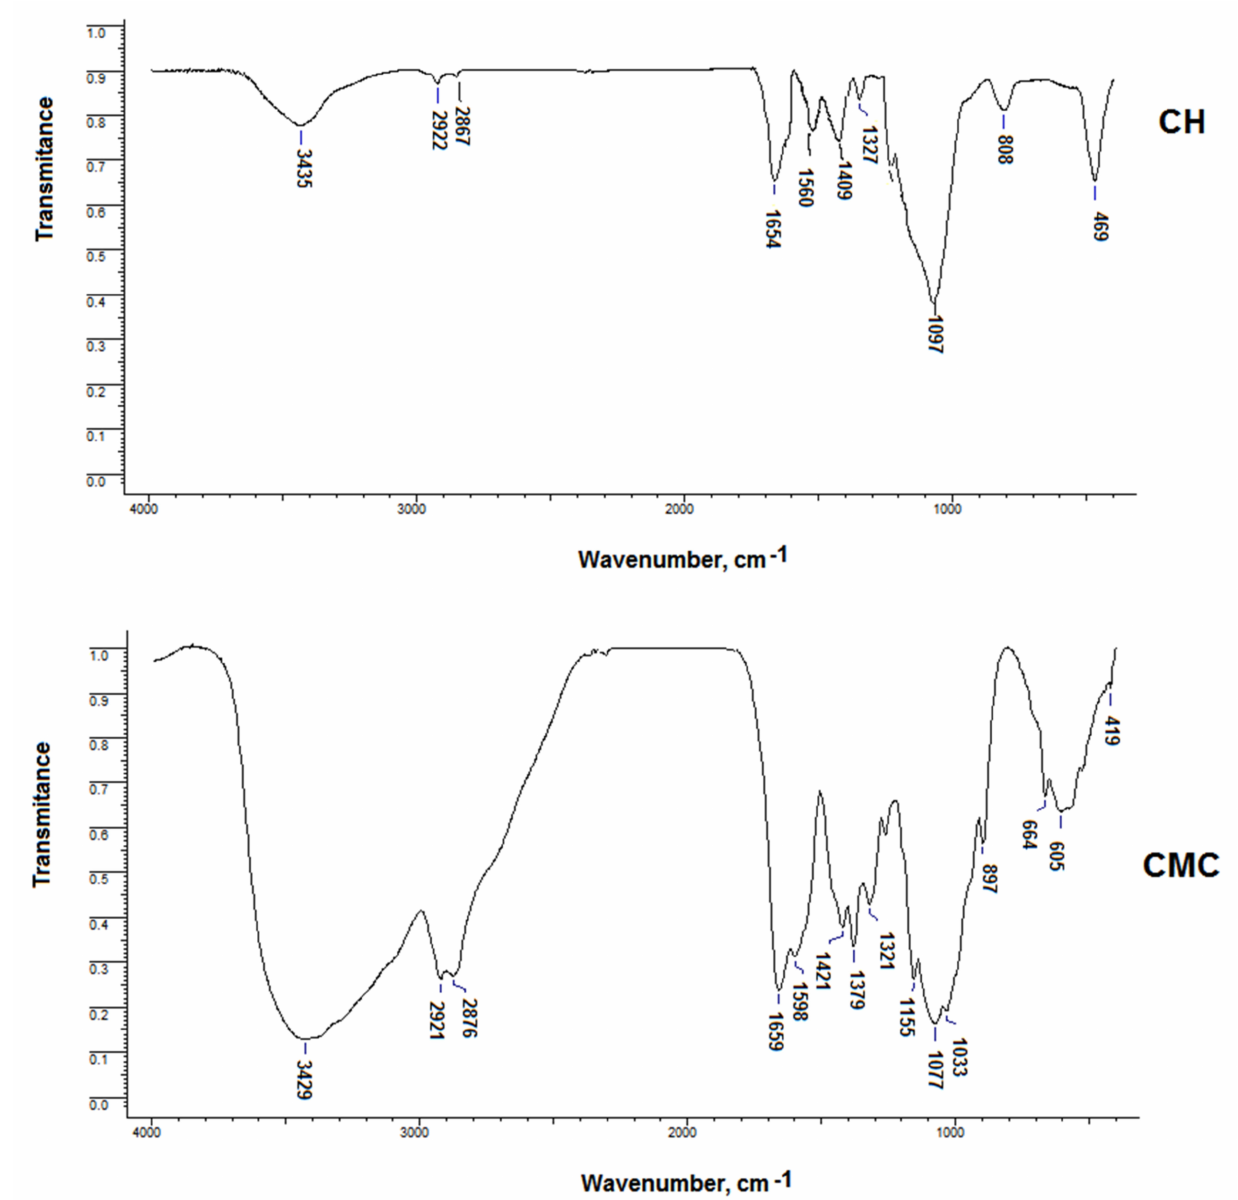
Figure 2. FTIR spectra of CH and